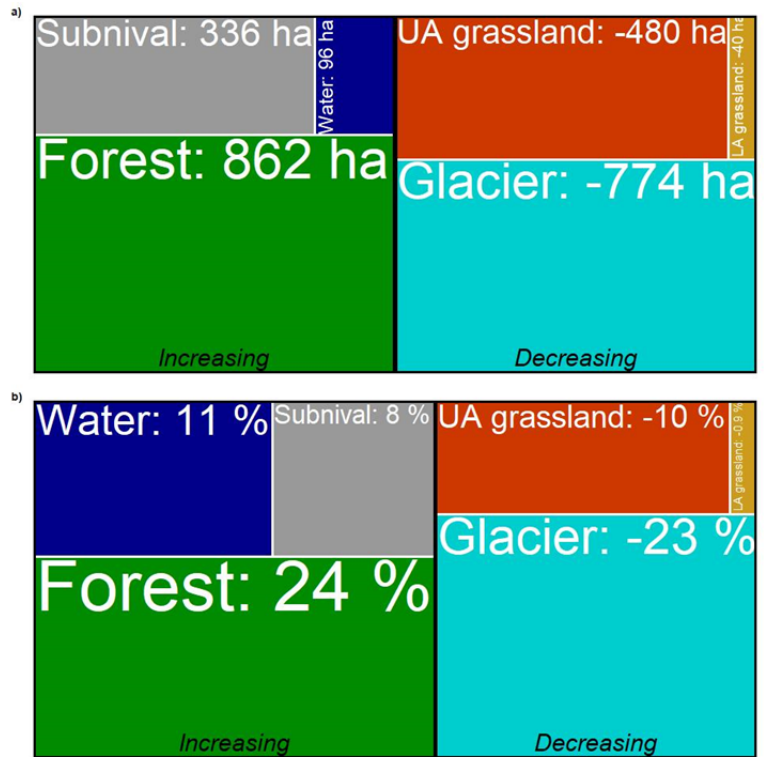
Figure 4. Trends in the occupied surfaces (ha) by the six land-cover types over thirty years (1987–2016) obtained using local polynomial regression. Vegetated and virtually unvegetated areas are shown in the two panels separately. Surfaces were obtained summing membership values of fuzzy clusters for each time window. The shaded colored areas refer to 95% confidence intervals.